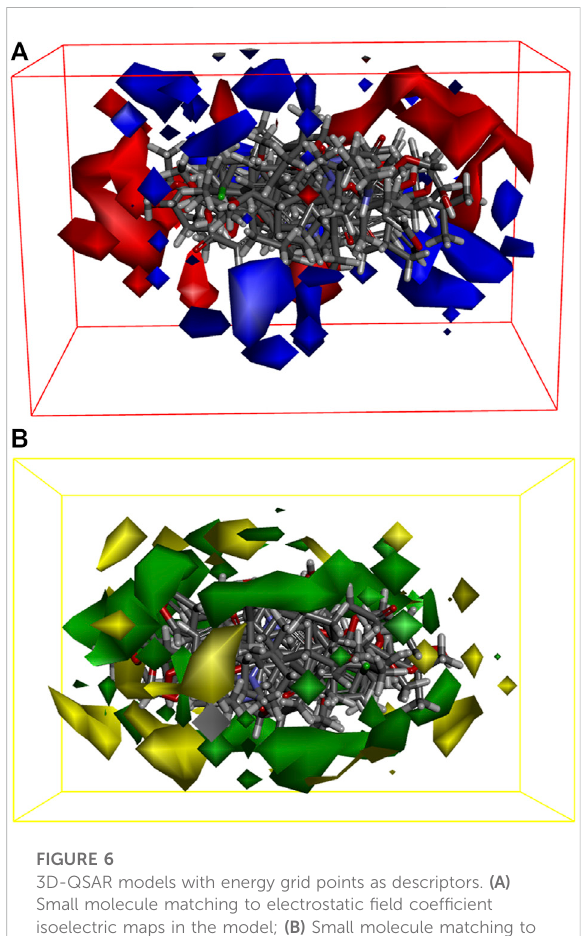
FIGURE 6 3D-QSAR models with energy grid points as descriptors. (A) Small molecule matching to electrostatic fi eld coef fi cient isoelectric maps in the model; (B) Small molecule matching to stereo fi eld coef fi cients isoplot in